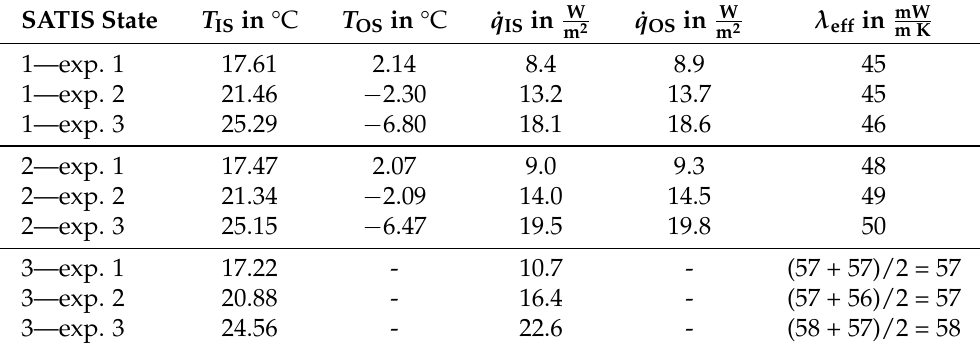
Table 5. Mean measured inside ( T IS , ˙ q IS ) and outside ( T OS , ˙ q OS ) surface temperatures and heat fluxes as well as calculated effective thermal conductivities for each manufacturing state of SATIS according to Equations (1) and (3).